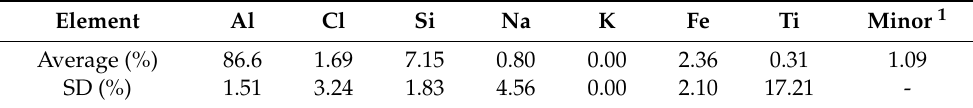
Table 3. Major element concentration (weight %) in the slag after leaching. Element